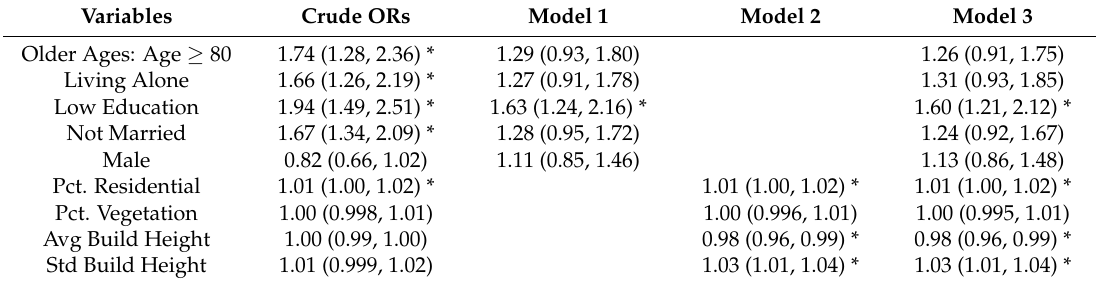
Table 3. Odds ratio of vulnerability variables to geriatric depression with significant variables are marked with asterisks. Models 1 and 2 are models with only social factors and only environmental factors, respectively, whereas Model 3 considers both social and environmental factors. * Indicates significant result with p -value <